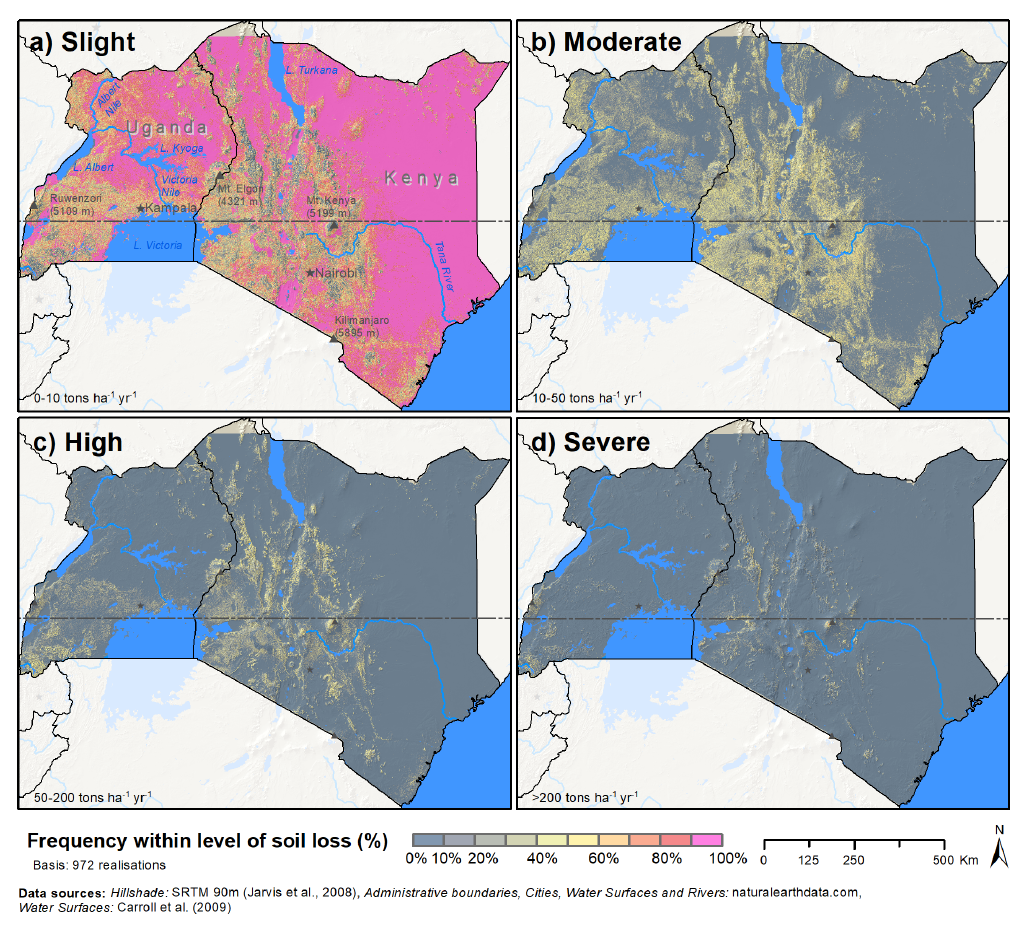
Figure 4. Frequency of USLE model ensemble members to predict one of the four soil loss classes slight (0–10tha − 1 yr − 1 ) (a) , moderate (10–50tha − 1 yr − 1 ) (b) , high (50–200tha − 1 yr − 1 ) (c) , and severe ( > 200tha − 1 yr − 1 ) (d) , based on the soil loss classification following FAO-PNUMA-UNESCO (1980). The pixel color illustrates the percentage of models from the model ensemble that calculated a soil loss in between the respective class